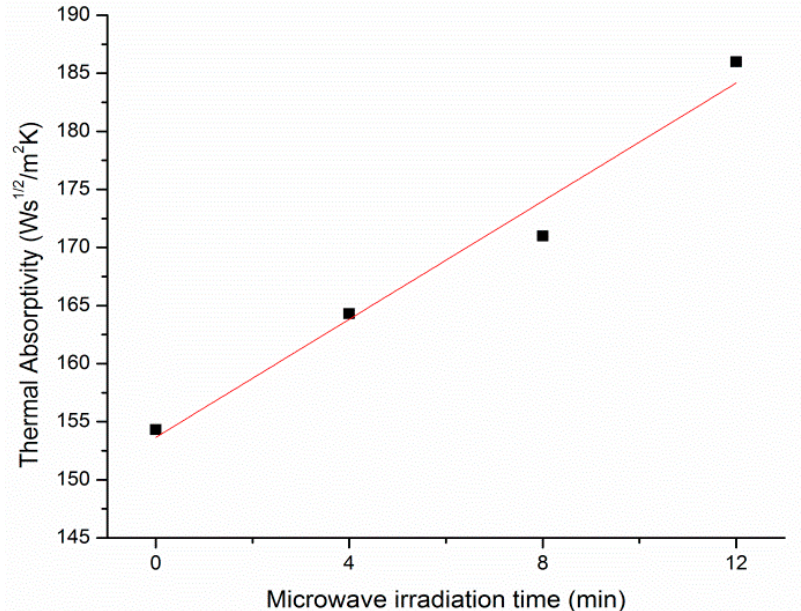
Figure 11. Thermal absorptivity of the ZnO-nanorod-coated fabrics at different microwave irradia- tion times.